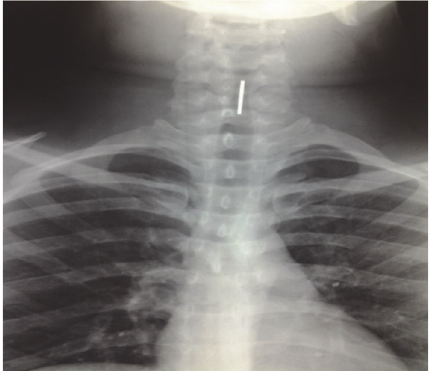
Figure1:FrontalX-ray:anteroposteriorviewshowinglinearopacity from C4 to C5.